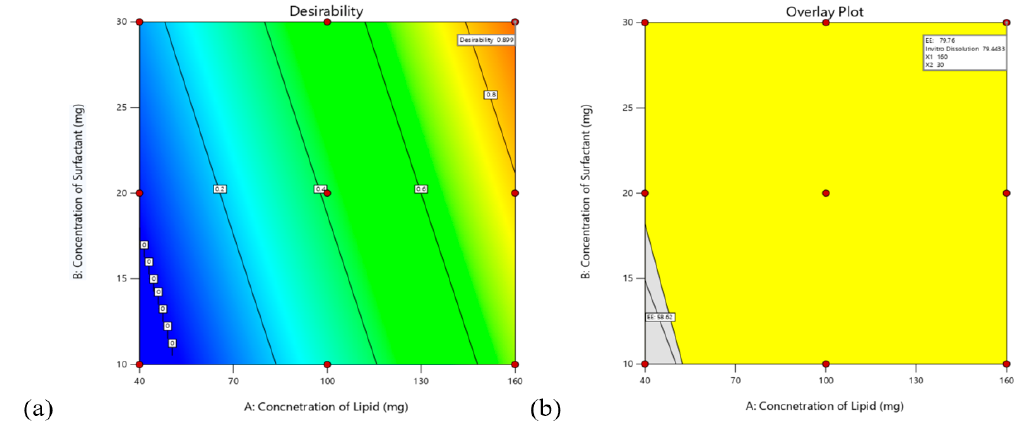
Figure 5. ( a ) Desirability plot by Numerical Optimization ( b ) Overlay plot by Graphical Optimiza- tion.